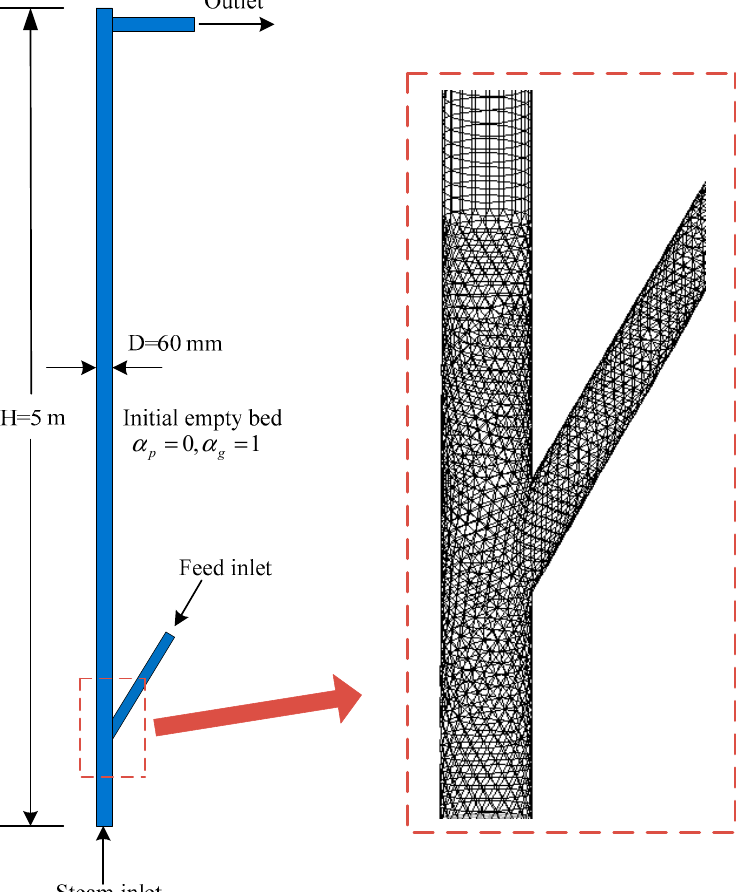
Figure 17. Sketch and grids of the CFB fuel reactor.